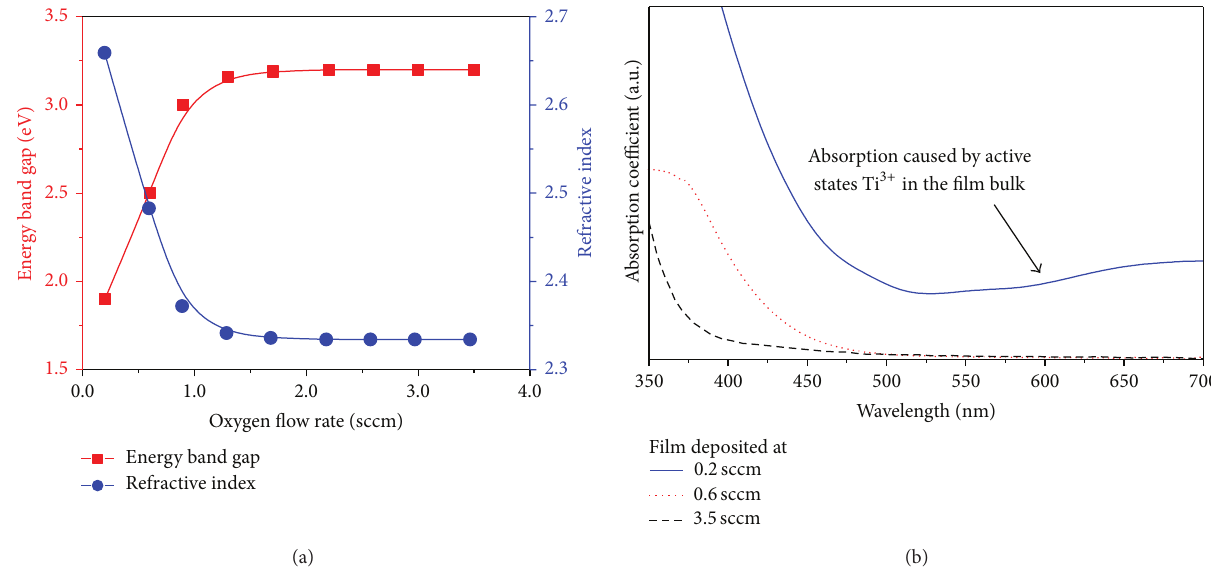
Figure 8: Energy band-gap (reproduced from [32]) and refractive index as function of the oxygen flow rate and (b) absorption coefficient for films deposited at 0.2, 0.6, and 3.5 sccm as function of photon wavelength.